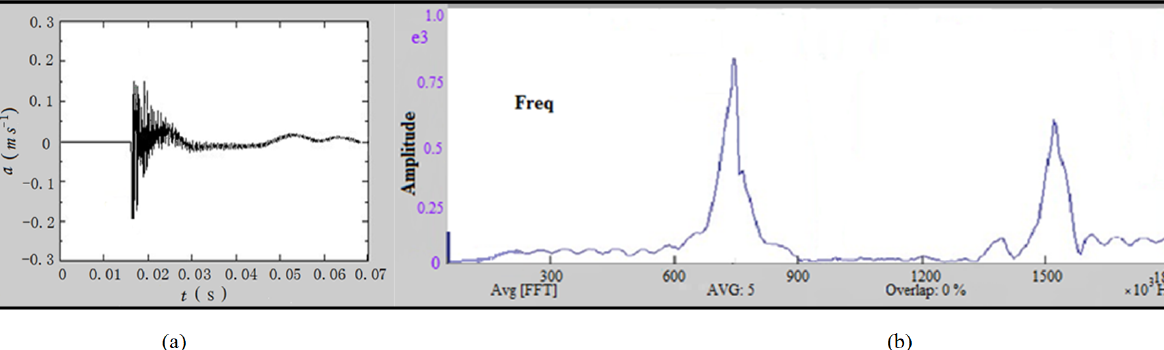
Figure 16. Acceleration signal and frequency spectrum.